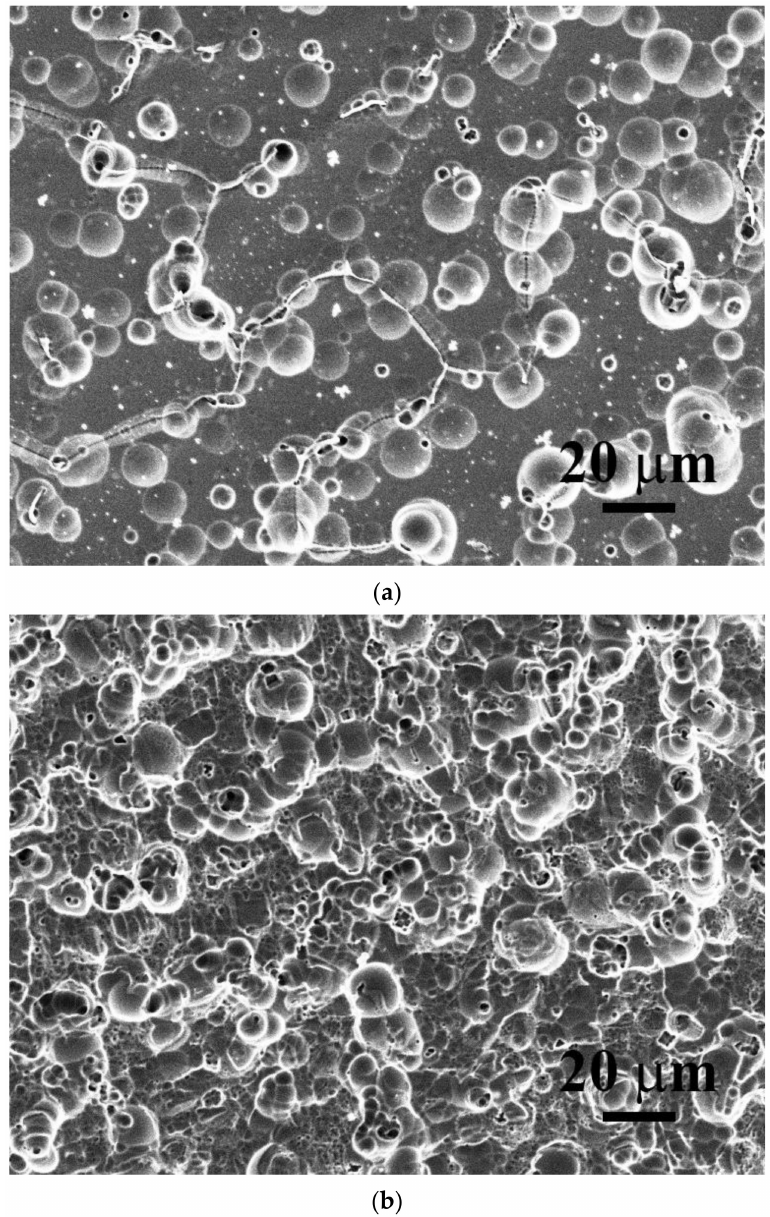
Figure 8. Morphologies of as-cast CoCrFeNiV x alloys after potentiodynamic polarization tests in 1M HCl solution: ( a ) CoCrFeNiV 0.5 alloy and ( b ) CoCrFeNiV